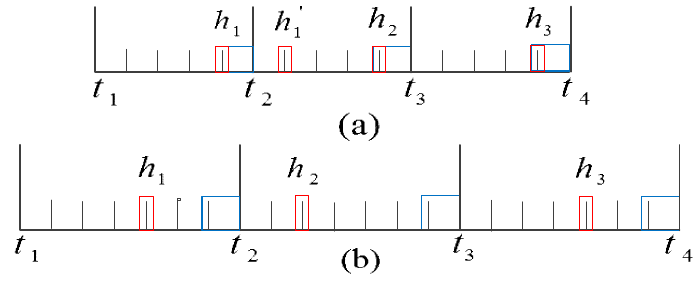
Figure 11. Schematic of impacts: ( a ) when SC cycle is 50 s and ( b ) when SC cycle is70 s.